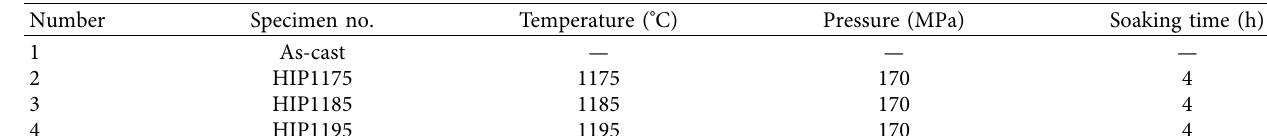
Figure 1: DSC results for the K417G alloy during the heating process. Table 2: Te HIP regimes applied in this study.